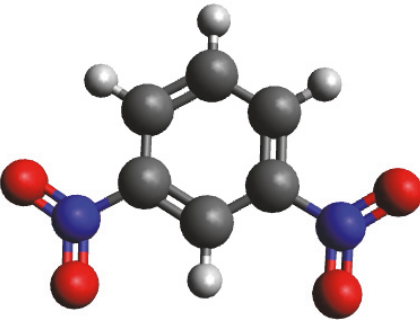
Figure 5: The ground state conformation of